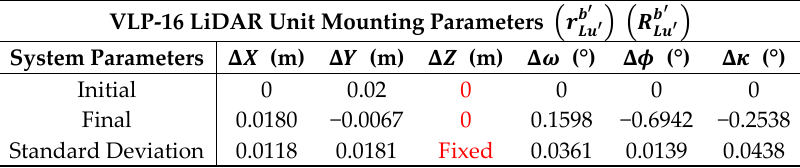
Table 4. Mounting parameters of VLP-16 before and after calibration test 2 (the parameter fixed during calibration is shown in red).